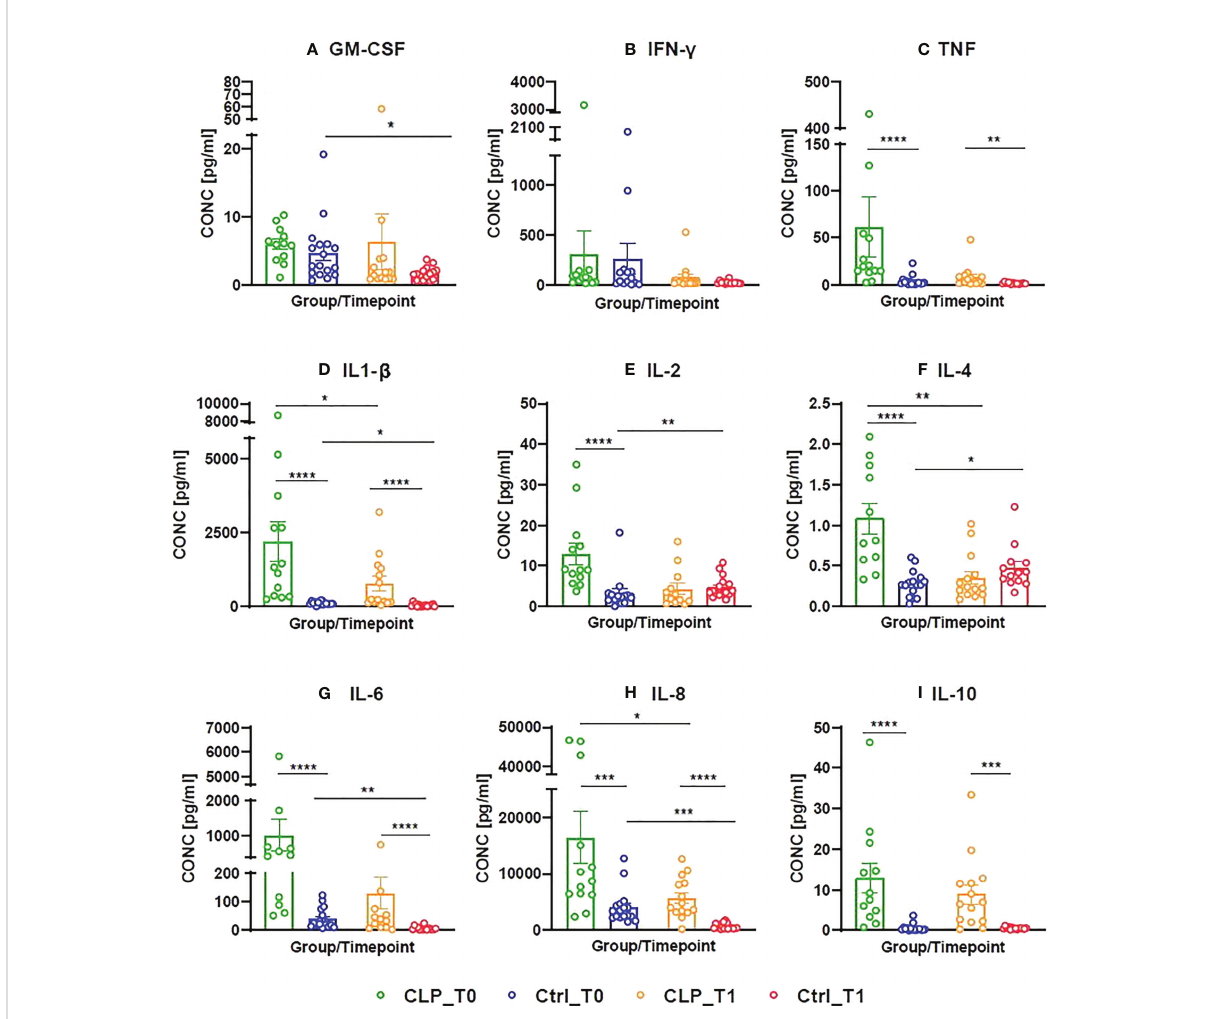
FIGURE 2 Concentrations (pg/ml) of measured cytokines (Granulocyte-macrophage colony-stimulating factor = GM-CSF, Interferon gamma = INF-y, Tumor-necrosis-factor = TNF, Interleukin (IL)-1ß/-2/-4/-6/-8/-10) in cleft patients (CLP) compared to controls (Ctrl) at both time points (T0 = after birth, T1 = 4-5 weeks after birth). A color scheme represents each group – time point – combination (CLP-T0: = green, Ctrl-T0 = blue, CLP-T1 = orange, Ctrl T1 = red). Histograms presenting the cytokine concentrations are given for each measured cytokine (A-I) , both groups (CLP vs. ctrl) and both time points (T0 vs. T1). Each histogram is a scatter dot plot with the mean and standard error of mean (SEM). The cytokine concentration in pg/ml is given on the Y axis, while the X axis represents the four groups: CLP_T0, Ctrl_T0, CLP_T1, Ctrl_T1. The comparisons were statistically analyzed with t test and Mann-Whitney U-test, statistically signi fi cant comparisons are indicated by *p ≤ 0.05, **p ≤ 0.01, ***p ≤ 0.001, **** p ≤